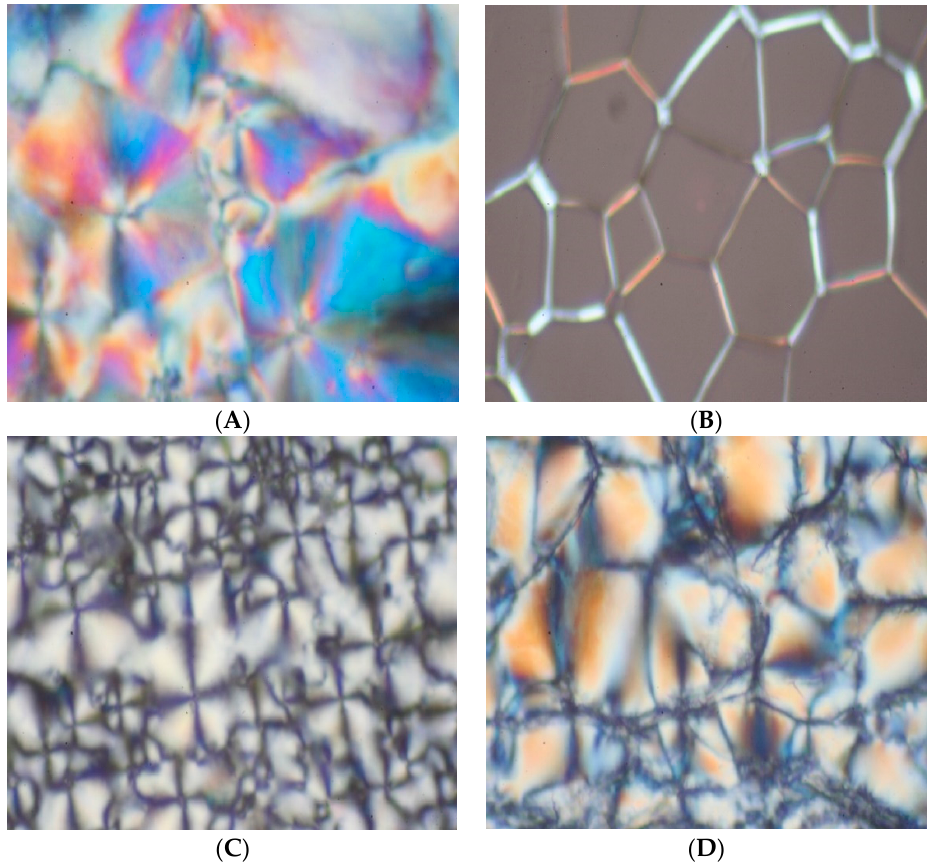
Figure 7. Typical textures observed by polarizing optical microscopy studies, revealing Schlieren or focal conic textures of ( A ) V8 at 230 °C ( B ) V9 at 260 °C ( C ) V10 at 190 °C ( D ) V12 at 200 °C on heating suggestive of their smectic A LC phases (magnification 400 ×).